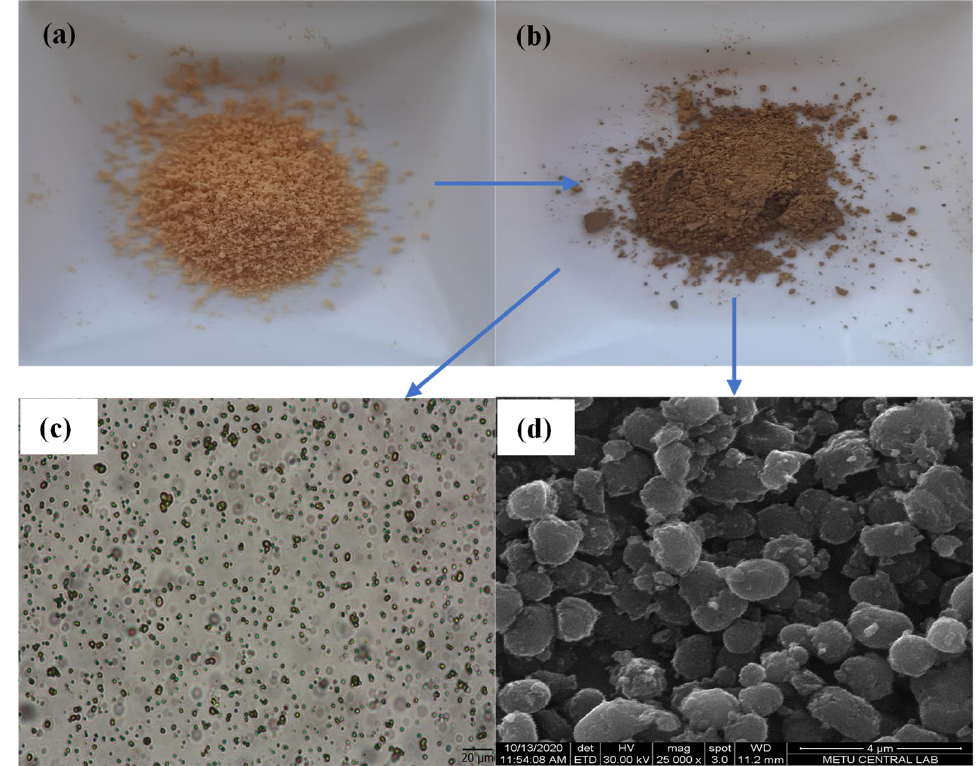
Figure 2. Digital camera image of ( a ) TA molecule, ( b ) p (TA) particles, ( c ) microscope image of p (TA) particles suspended in DI water, and ( d ) SEM image of p (TA) particles.